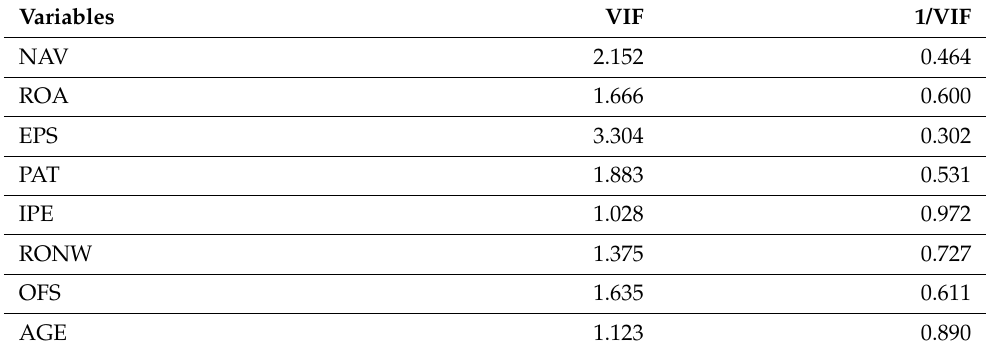
Table A2. Collinearity Statistics.